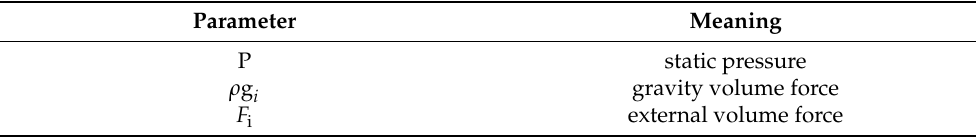
Table 3. Parameter meaning of momentum conservation